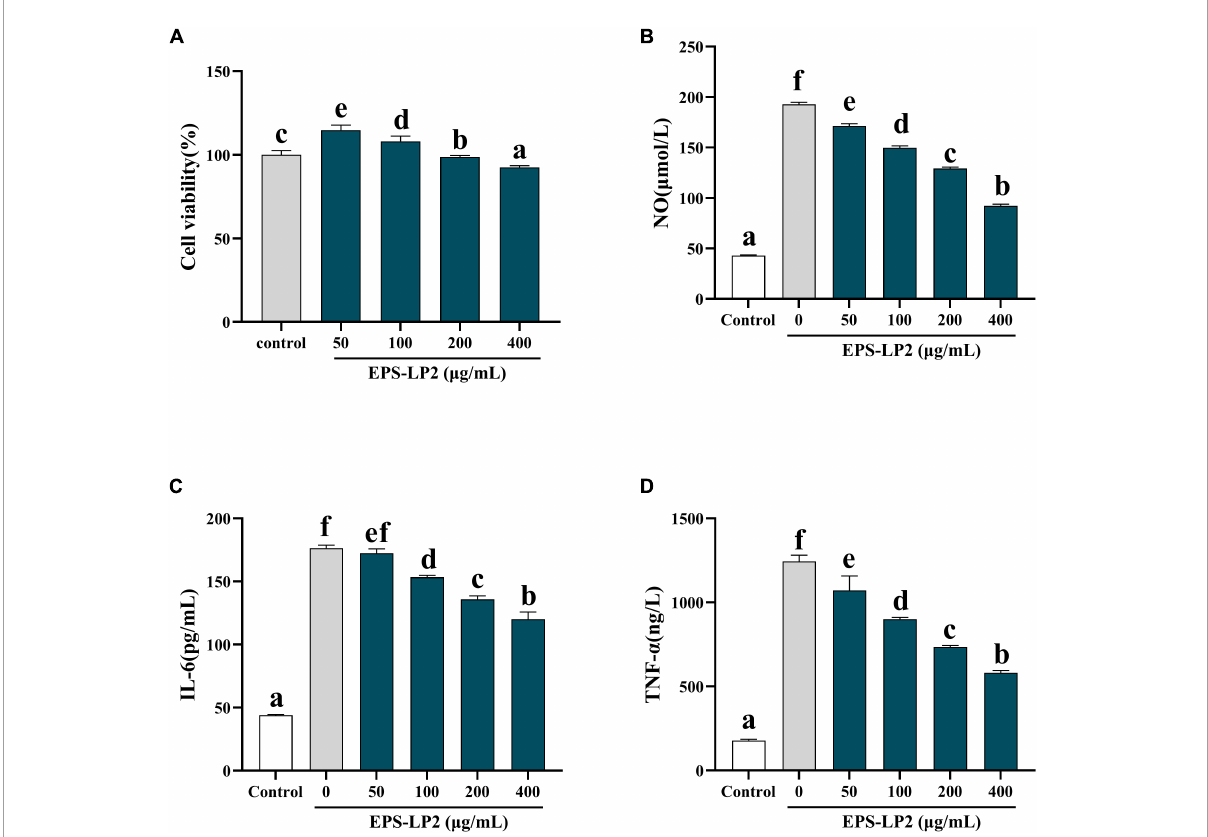
FIGURE5 Effects of exopolysaccharides (EPS)-LP2 on (A) cell viability, (B) nitric oxide (NO) production, expression of (C) interleukin 6 (IL-6), (D) tumor necrosis factor- α (TNF- α ) in RAW264.7 cells induced by lipopolysaccharid (LPS). Different letters represent different significance from the control group ( p <